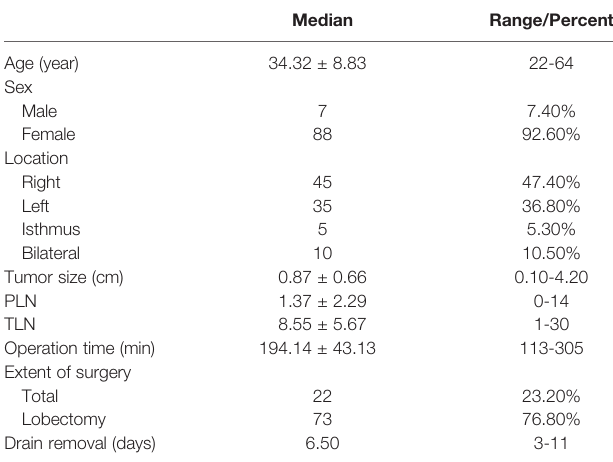
TABLE 1 | Patients characteristics (n =